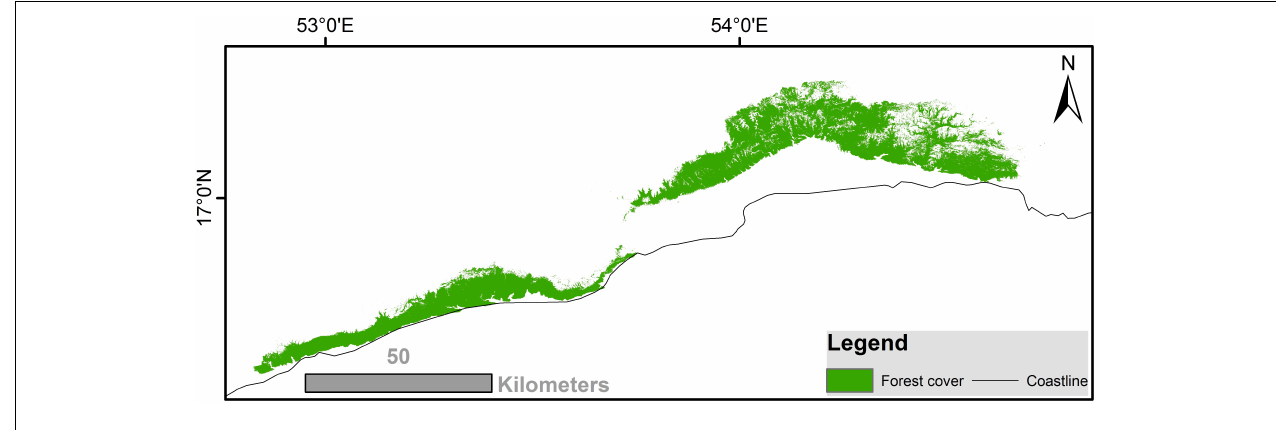
FIGURE 5 | Maximum forest cover from 1987 to 2017 based on Landsat 5, 7, and 8 data.